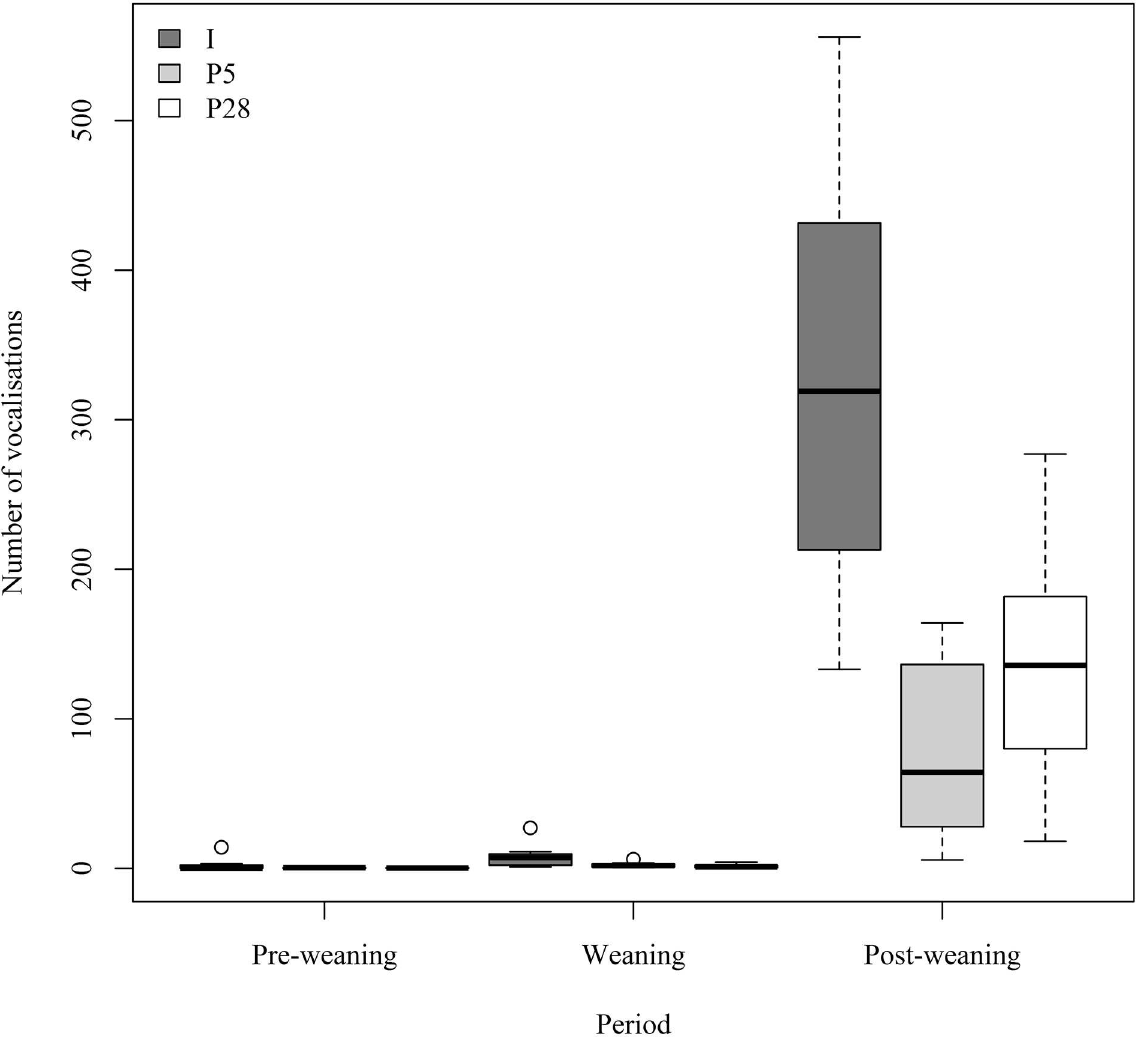
Fig 1. Vocal responses of calves to weaning. The total number of vocalisations, duringone hour observations of calves, over each three-dayperiod(pre-weaning, weaningand